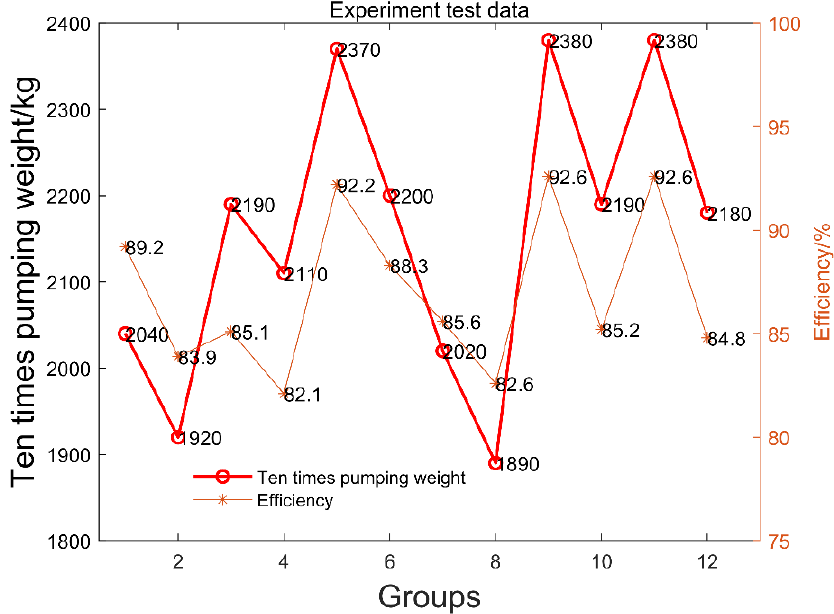
Figure 10. Concrete pumping efficiency and mass.